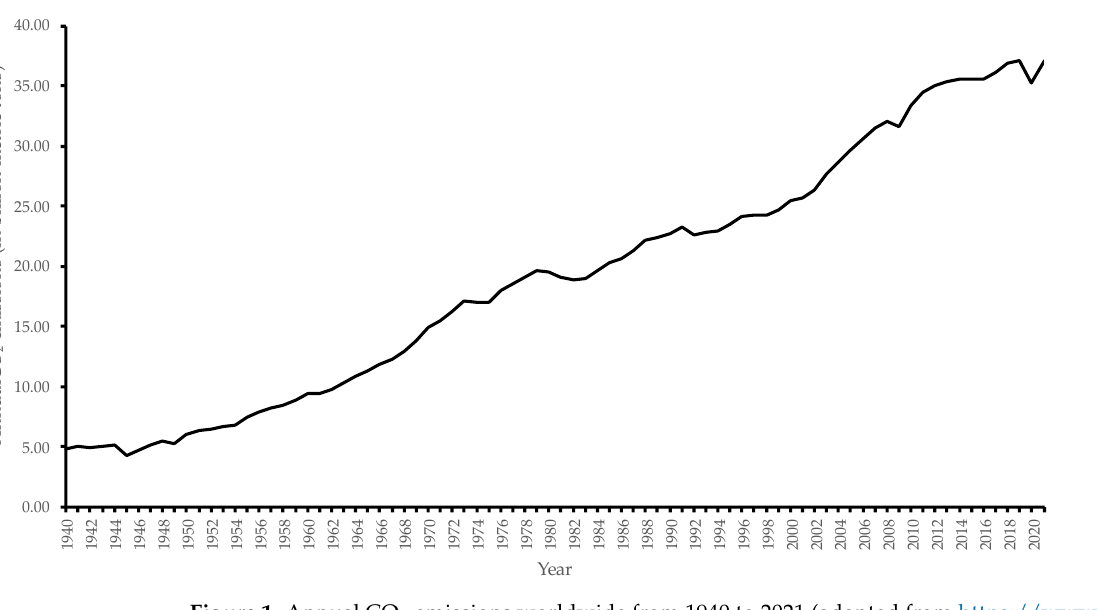
Figure 1. Annual CO 2 emissions worldwide from 1940 to 2021 (adapted from https://www.statista. Figure 1. Annual CO₂ emissions worldwide from 1940 to 2021 (adapted from https://www.sta- com/, accessed on 15 March tista.com/, accessed on 15 March 2023).